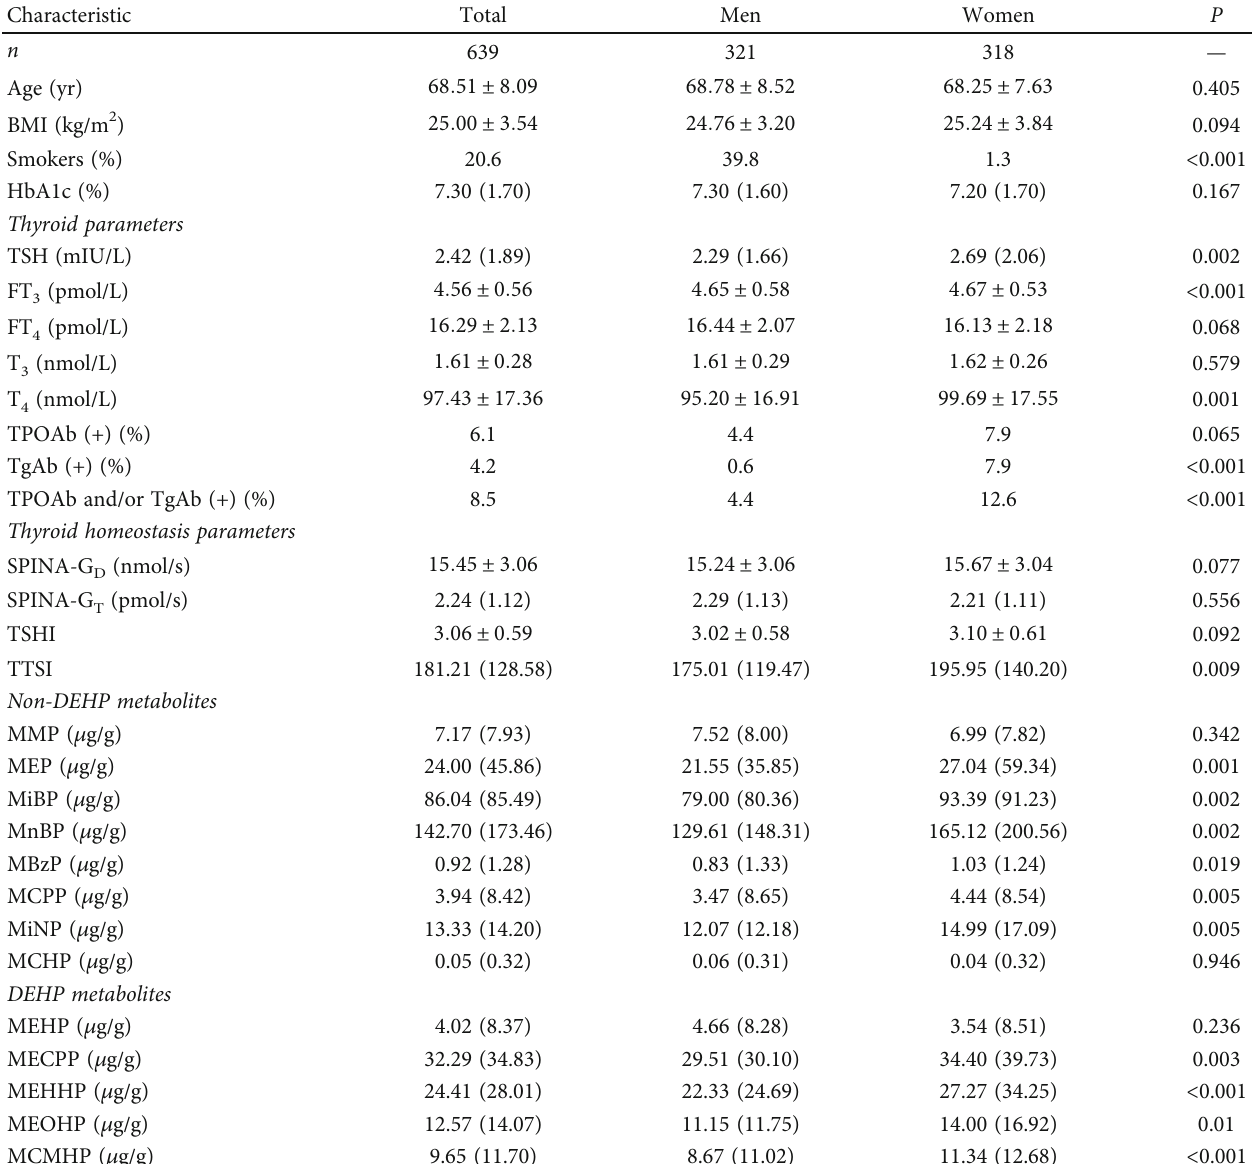
Table 1: Characteristics of the study